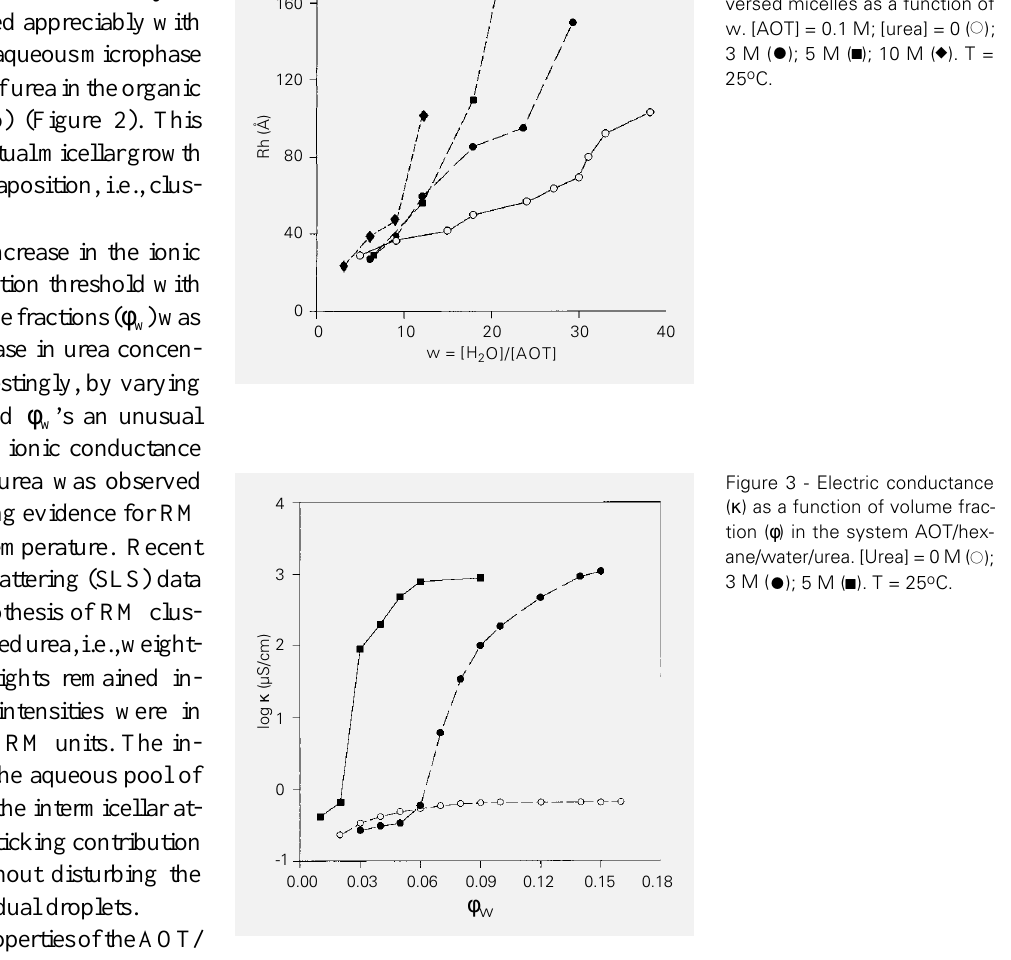
Figure 2 - Hydrodynamic radii (Rh) of AOT/hexane/water re- versed micelles as a function of w. [AOT] = 0.1 M; [urea] = 0 ( ! );